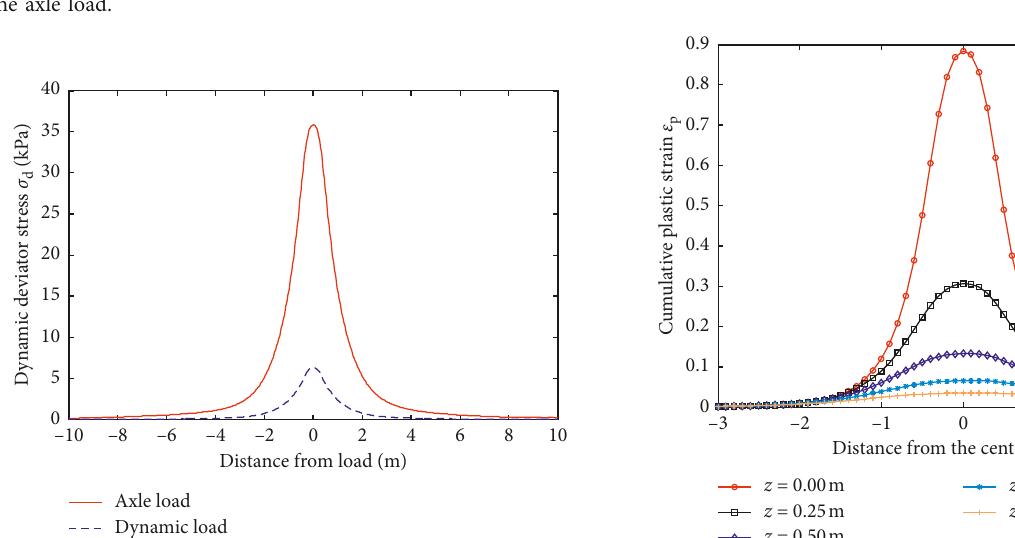
Figure 4: Distributions of the dynamic deviator stress σ subgrade top surface.